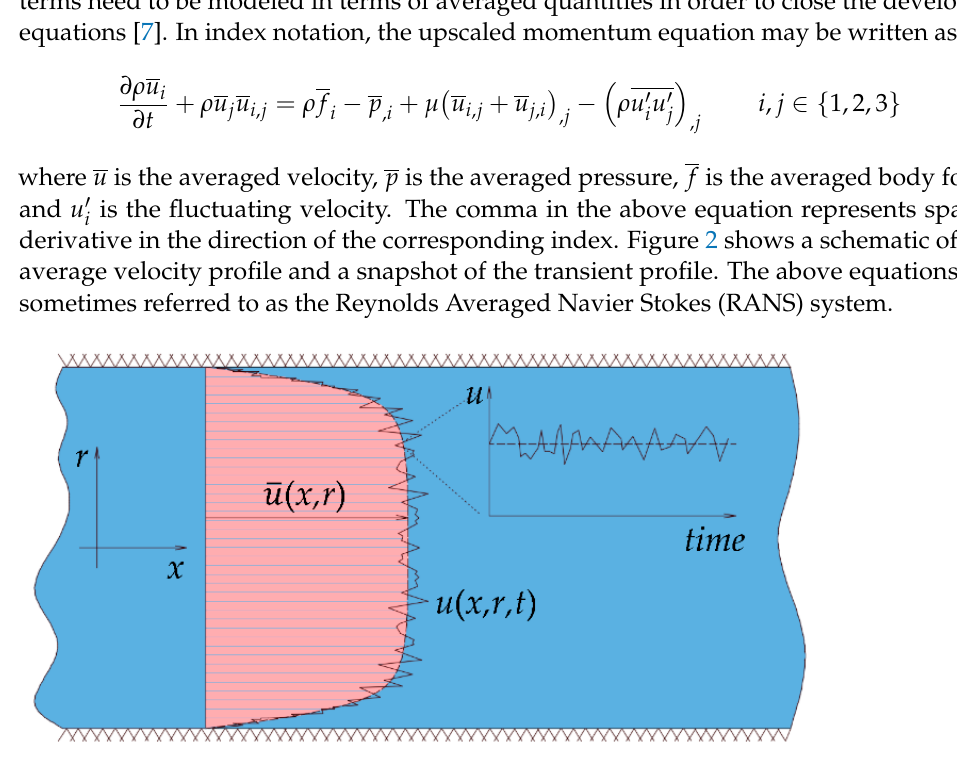
Figure 2. Schematic of the average velocity profile along with a snapshot of the time-varying profile.